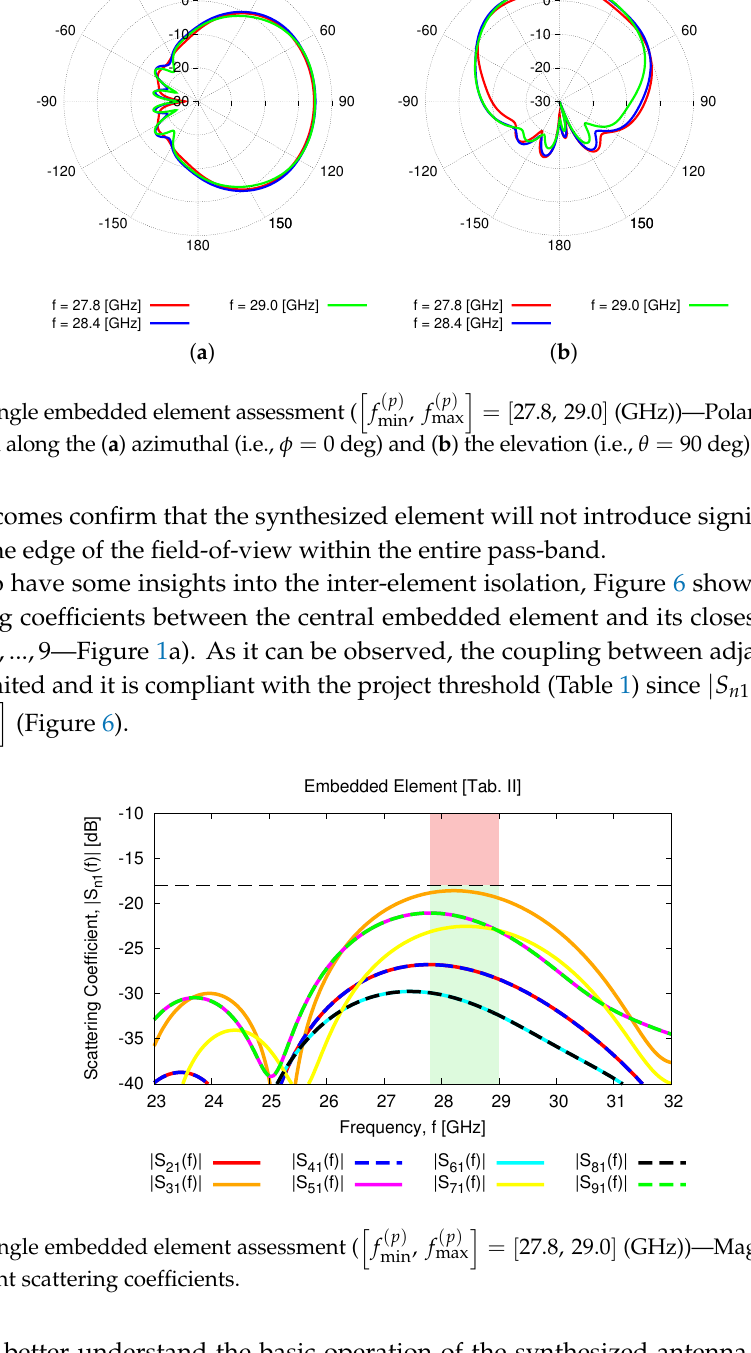
(cid:104) (cid:105) ( p ) ( p ) = [ 27.8, 29.0 ] (GHz))—Magnitude of the f , f max min